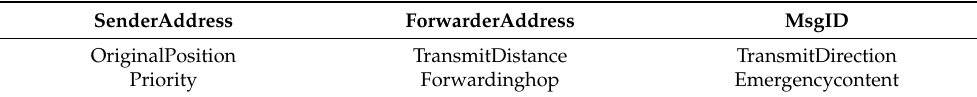
Table 2. The structure of the emergency message.